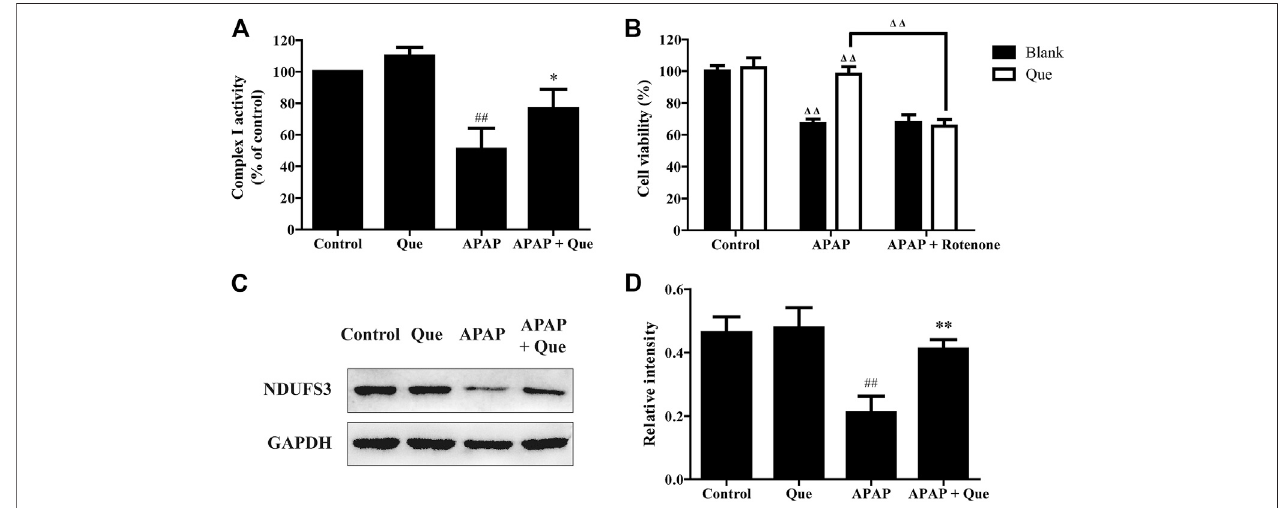
FIGURE 7 | Effect of quercitrin on mitochondrial complex I. (A) Effect of quercitrin on the activity of complex I in L-02 cells. (B) Effect of APAP and rotenone treatmentonL-02cellsviabilityintheblankgroupandQuegroup. (C) WesternblotanalysisofNDUFS3(complexI)inL-02cells. (D) Westernblotdensitometric analysis. The experimental data are expressed as mean ± SD, and the experiment was repeated three times, ## p < 0.01, compared with the control group; * p < 0.05, ** p < 0.01, compared with the APAP group; ΔΔ P < 0.01, the APAP-treated blank group was compared with the control group, the Que group was compared with the blank group, and the APAP + rotenone group was compared with the APAP